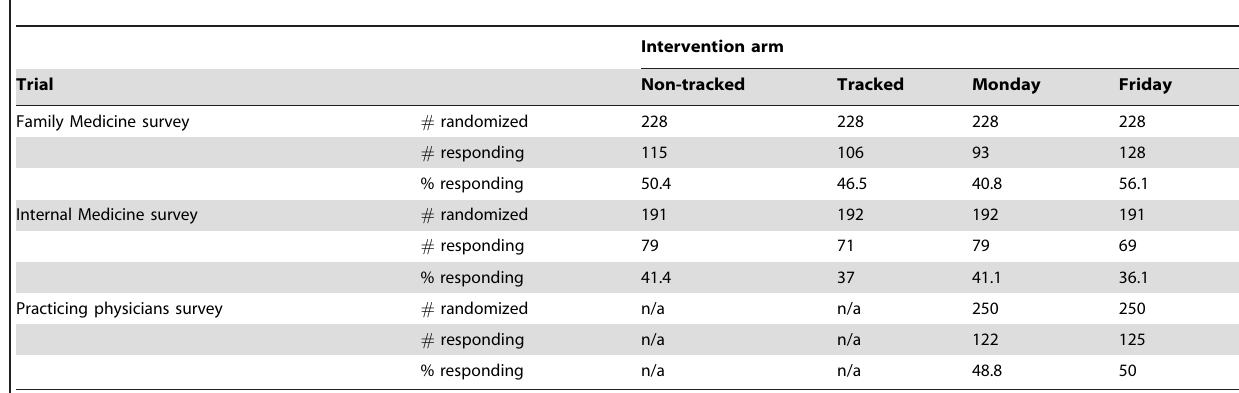
Table 1. Number of participants randomized and number responding by the time of the 2 nd reminder for each trial and for each of the intervention